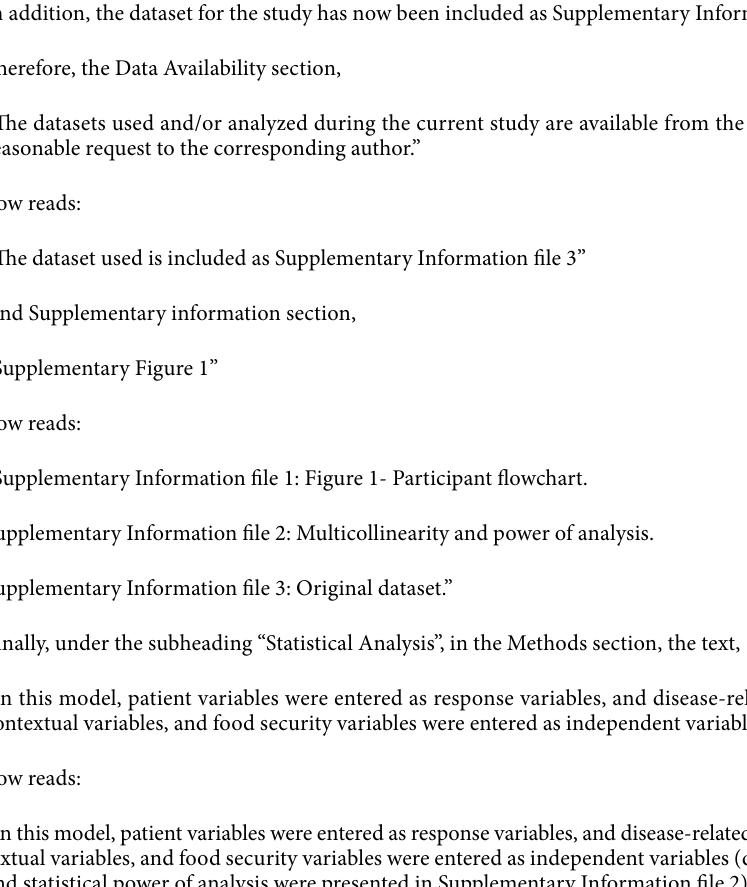
“Supplementary Information file 1: Figure 1- Participant flowchart. Supplementary Information file 2: Multicollinearity and power of analysis. Supplementary Information file 3: Original